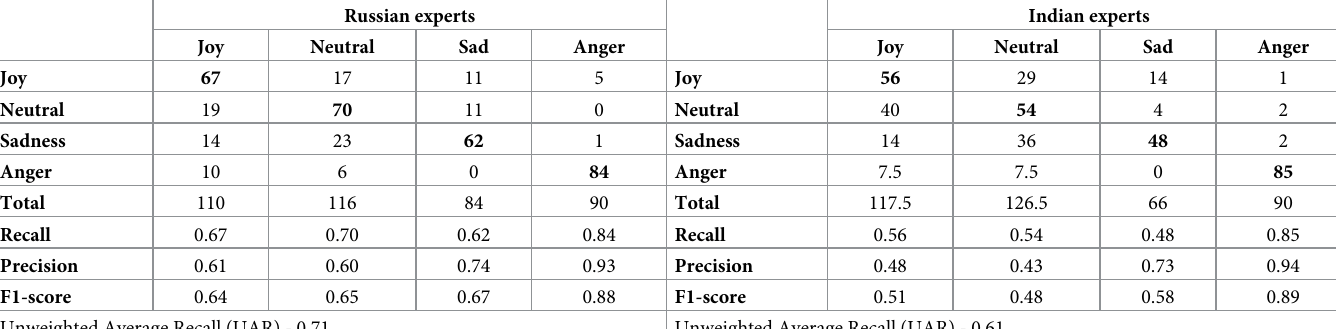
Table 11. Confusion matrix for emotion classification in the meaningless text of Tamil children by Russian and Indian experts. Russian experts